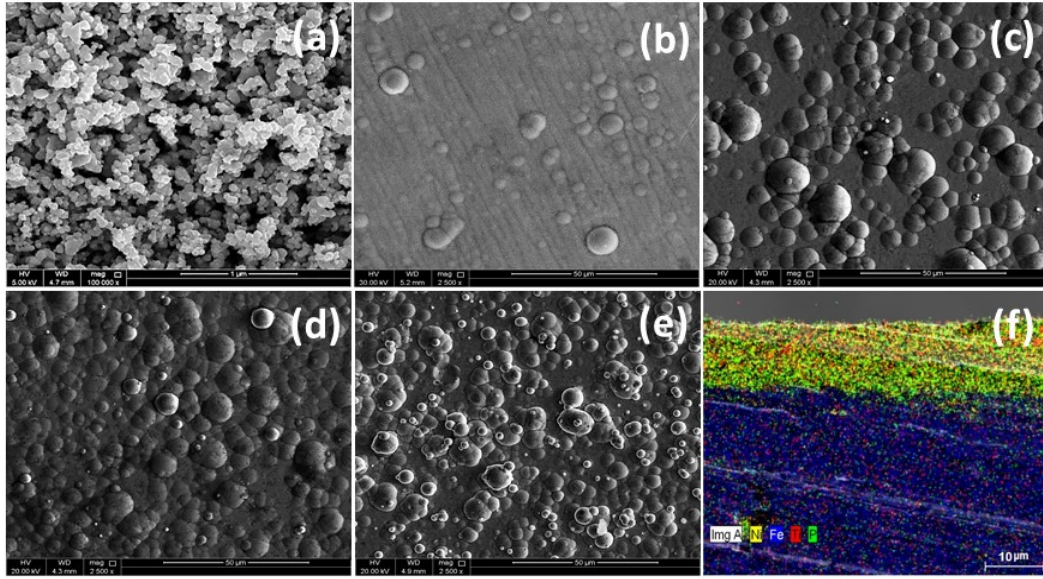
Figure 2. Field emission scanning electron microscope (FESEM) image of the Ti nanoparticles (TNPs)—( a ), nickel phosphorus (NiP)—( b ), NiP-0.25TNPs—( c ), NiP-0.50TNPs—( d ), NiP-1.0TNPs—( e ) and cross-section view for NiP-0.50TNPs—( f ). Elemental mapping of cross-section of NiP-0.50TNPs nanocomposite coatings.